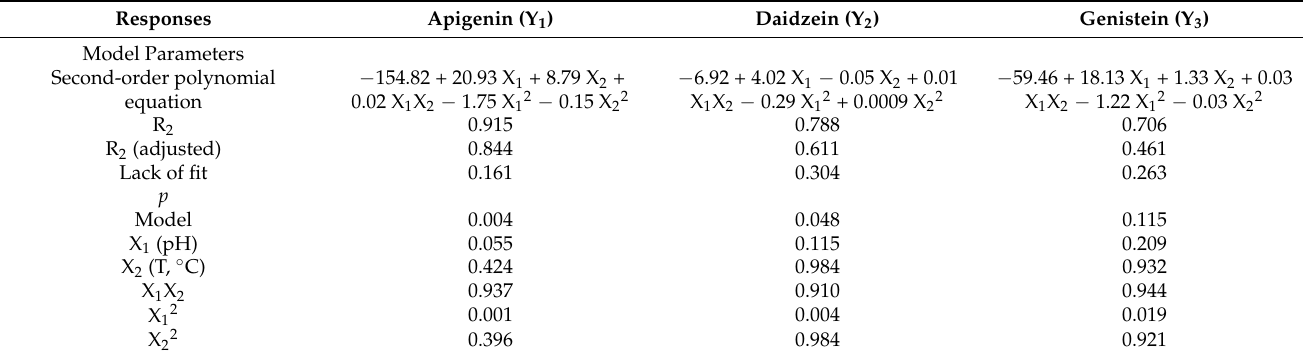
Table 2. Polynomial equations and statistical parameters of the fitted models obtained for response variables.